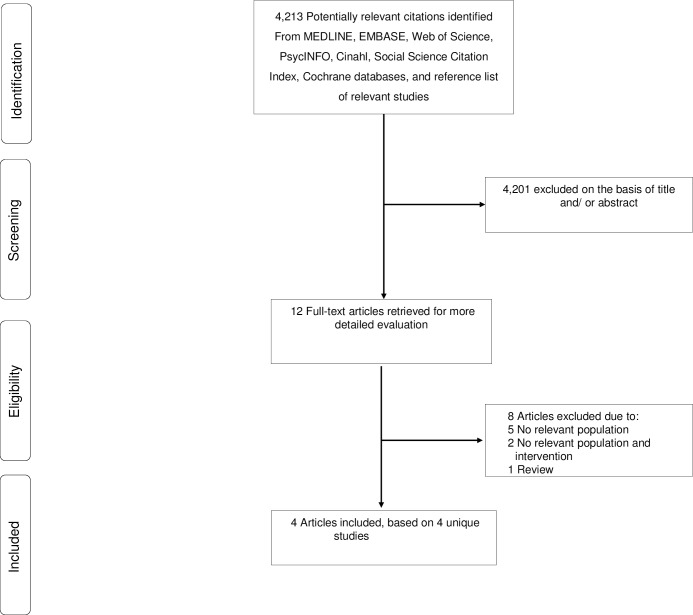
PRISMA Flow Diagram.